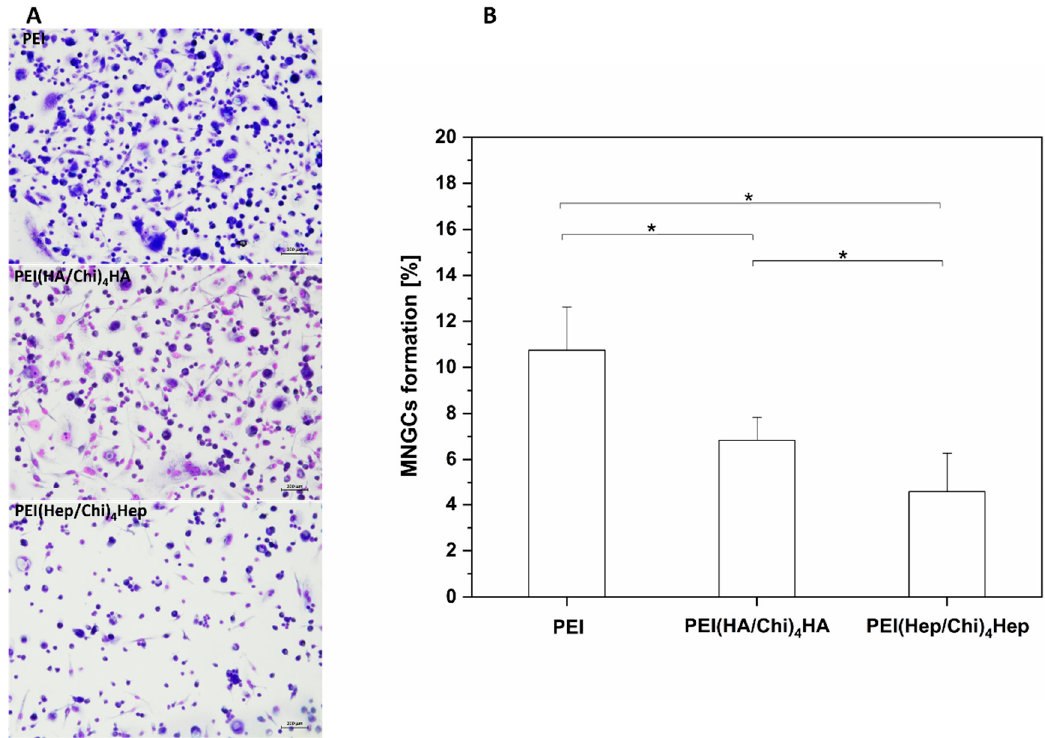
Figure 6. ( A ) Images of multinucleated giant cells (MNGCs) stained with 10% (v / v) Giemsa after 10 days cultivation on poly (ethylene imine) (PEI) and terminal layers of PEMs composed of either hyaluronic acid (HA) or heparin (Hep) as polyanions and chitosan (Chi) as polycation abbreviated as (PEI(HA / Chi) 4 HA, PEI(Hep / Chi) 4 Hep), respectively. Scale bar: 100 µ m. ( B ) The area percentage of MNGCs on PEI, PEI(HA / Chi) 4 HA and PEI(Hep / Chi) 4 Hep surfaces based on quantitative image analysis of micrographs. Results represent means ± SD, * p < 0.05, n = 15.